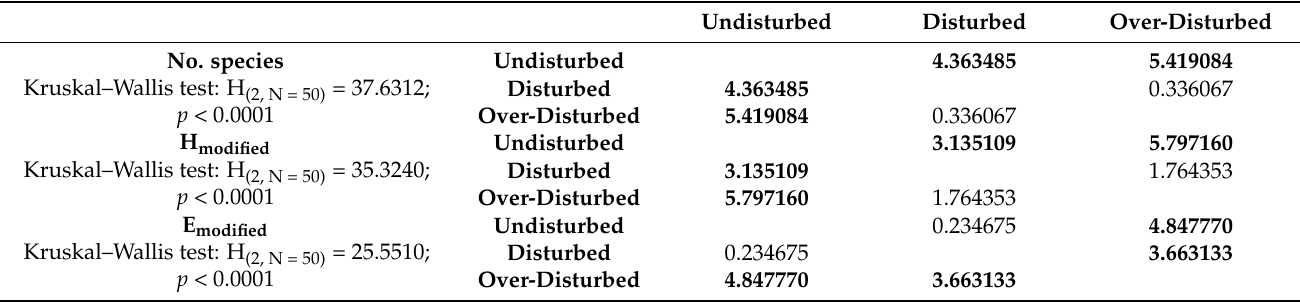
Table 5. Multiple comparisons z’ values for number of species, H modified , and E modified considered separately according to the disturbance level. Significant values are in